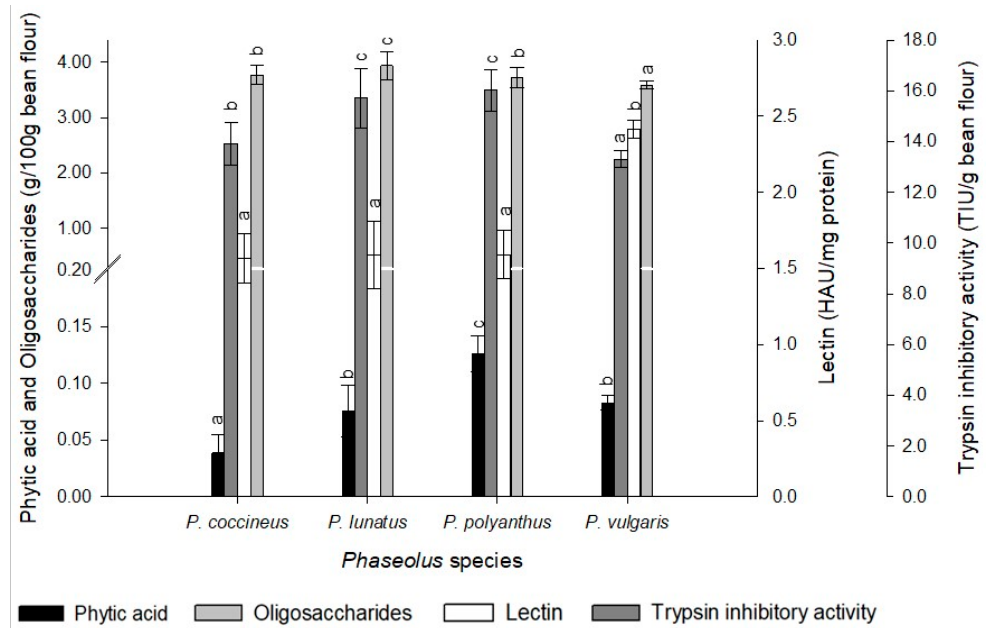
Figure 5. Antinutritional components of bean varieties by Phaseolus species. Mean values ± SD with different letters indicate statistically significant differences according to Tukey’ test ( p < 0.05).